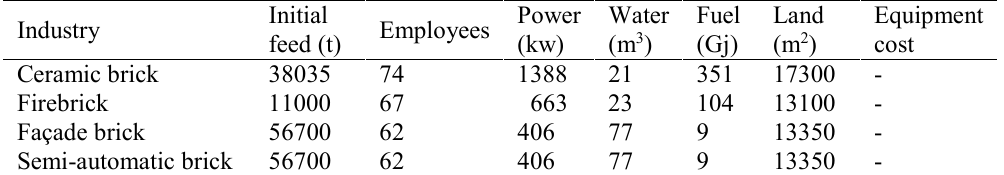
Table 2. Assessment matrix based on main factors of FMBMI